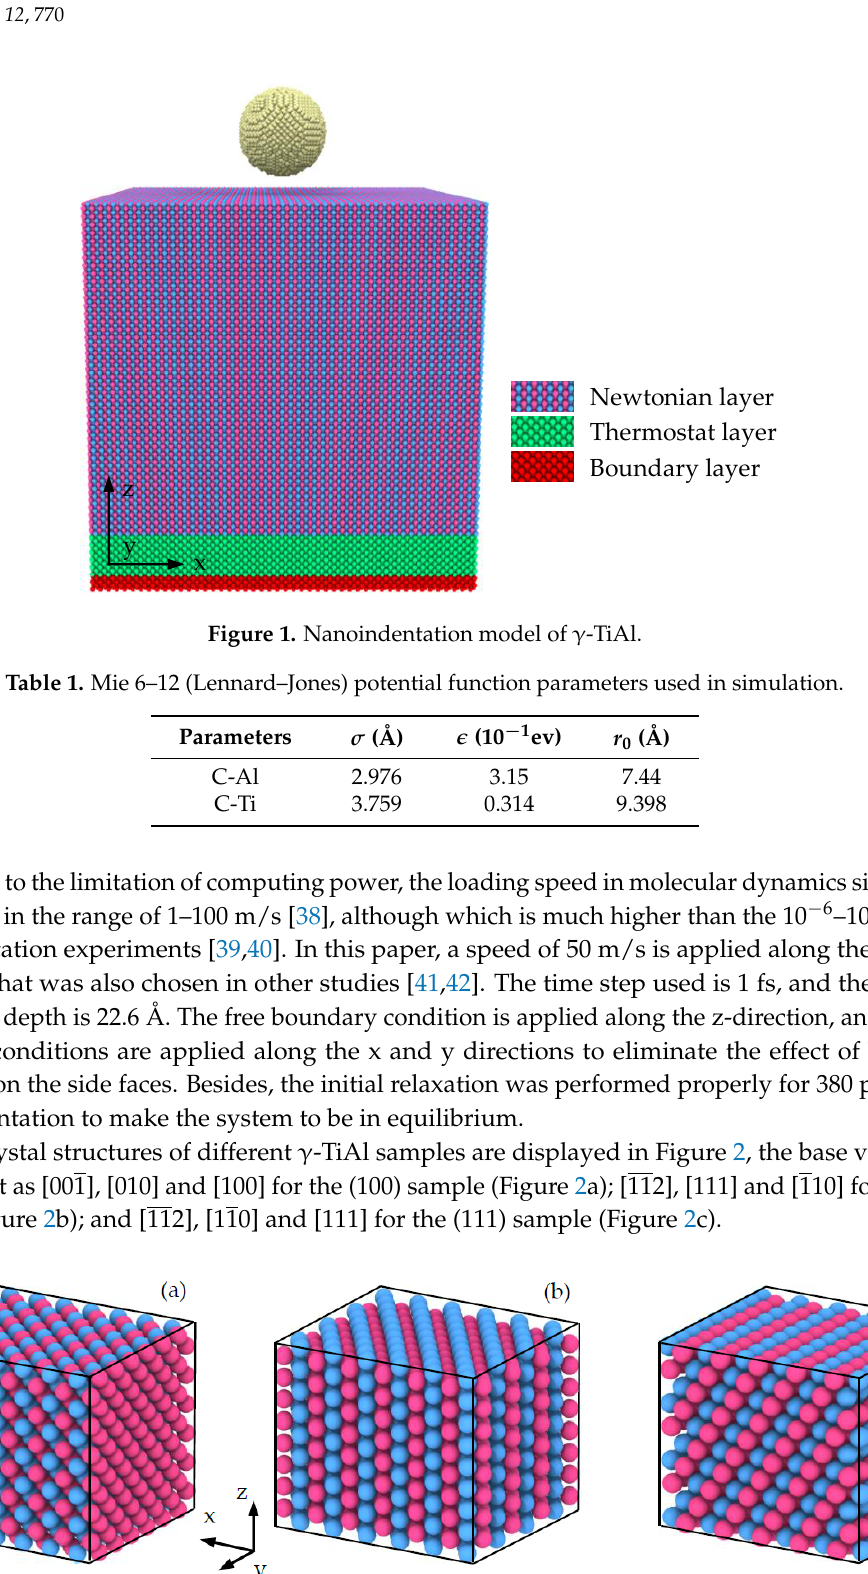
Figure 2. The crystal structure of ( a ) the (100) sample, ( b ) the (110) sample and ( c ) the (111) sample. The Ti atoms are colored purple and the Al atoms are colored blue.